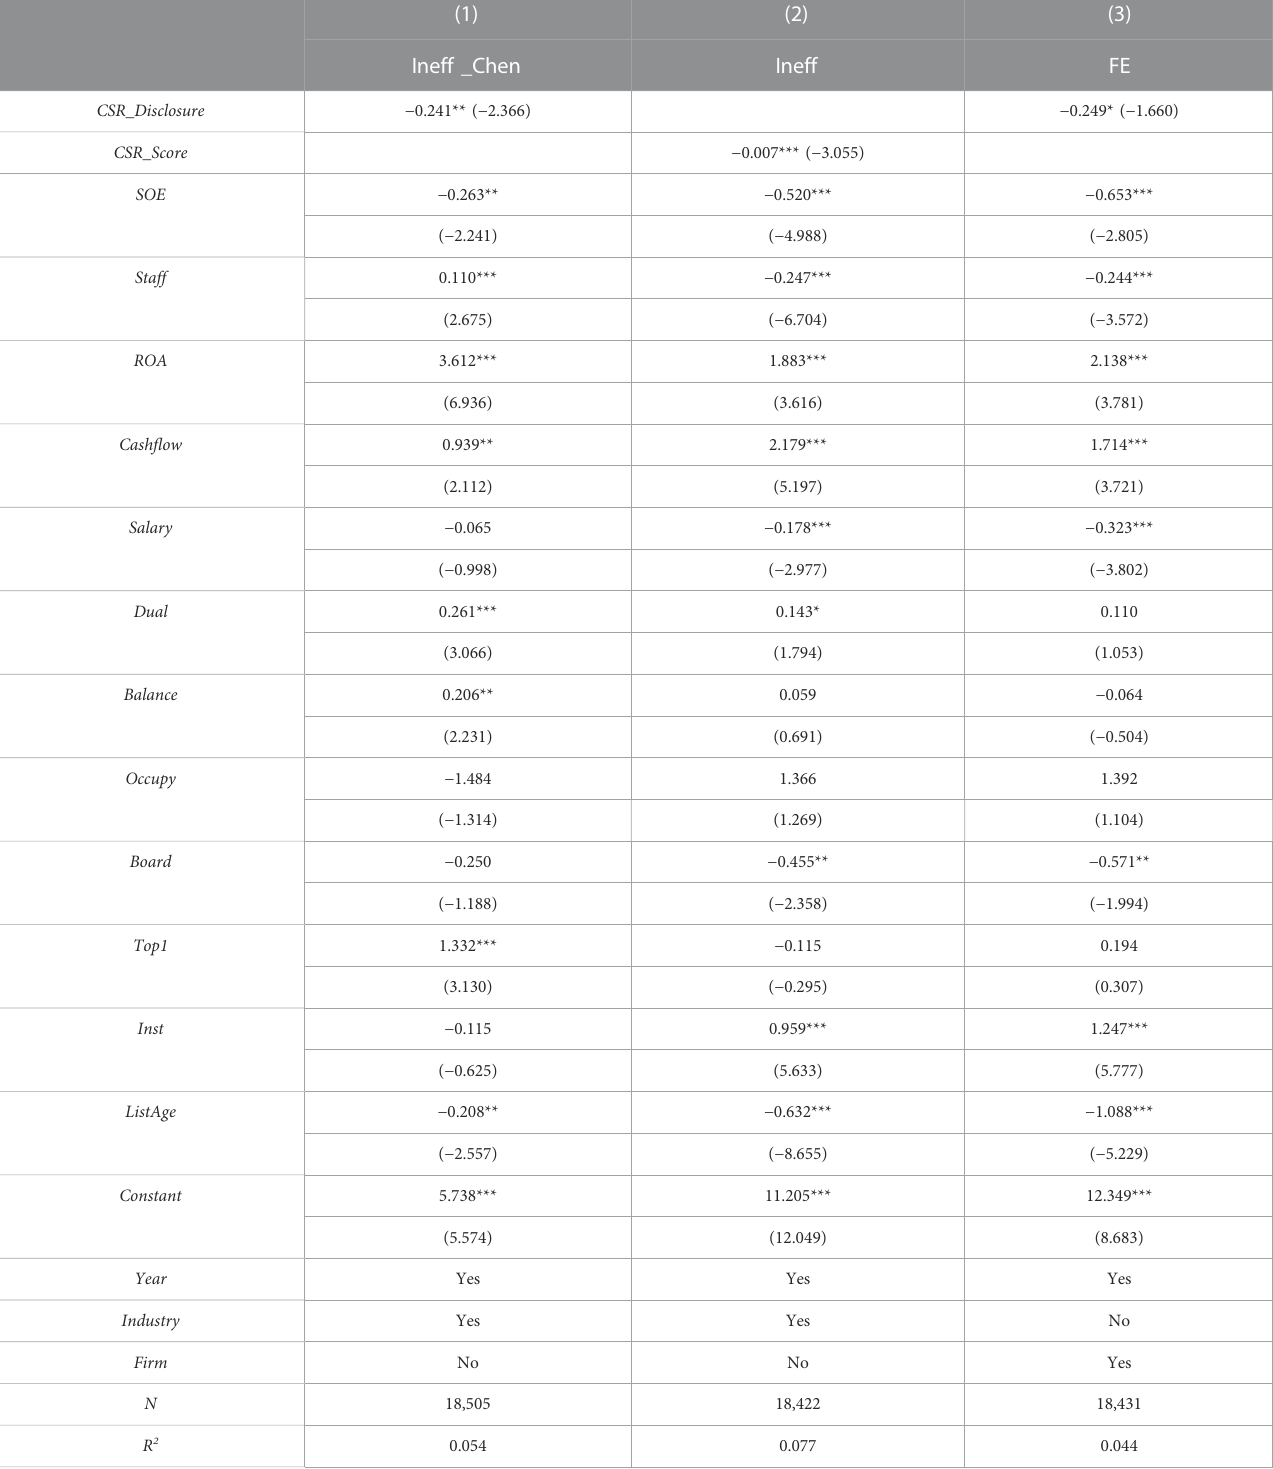
TABLE 8 The relation between CSR disclosure and fi rms ’ investment ef fi ciency in robustness